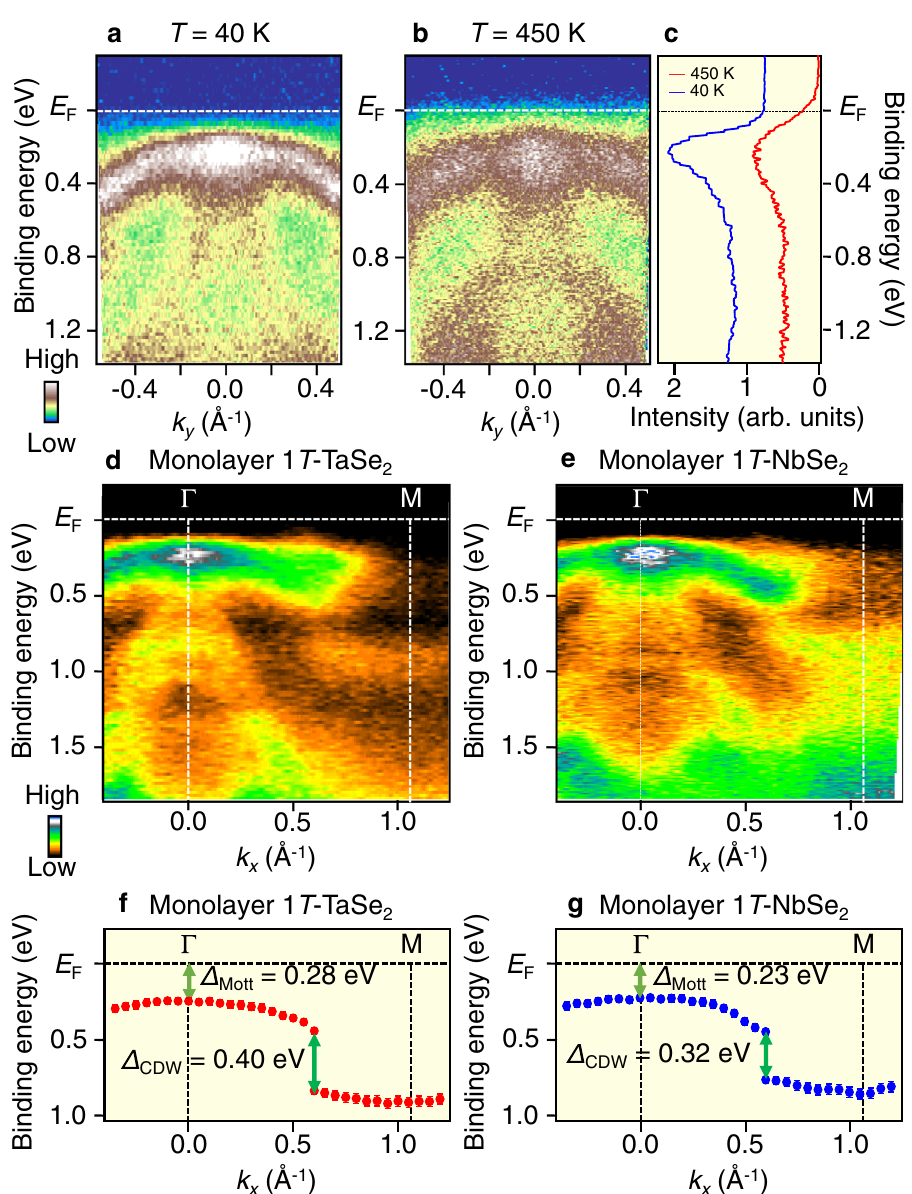
Fig. 4 Comparison of the CDW – Mott phase between monolayer NbSe 2 and TaSe 2 . a , b ARPES intensity of monolayer 1T-NbSe 2 at T = 40 and 450 K, respectively, measured along the Γ K cut. c EDCs at the Γ point at T = 40 and 450 K. d , e Valence-band ARPES intensity along the Γ M cut for monolayer NbSe 2 and TaSe 2 , respectively. f , g Experimental band dispersion extracted by tracing the peak position in EDCs for monolayer TaSe 2 and NbSe 2 , respectively, highlighting the quantitative difference in the magnitude of the Mott – Hubbard gap ( Δ Mott ) and the hybridization gap associated with CDW ( Δ CDW ). Error bars in e re fl ect the uncertainties originating from the energy resolution and the standard deviation in the peak positions of